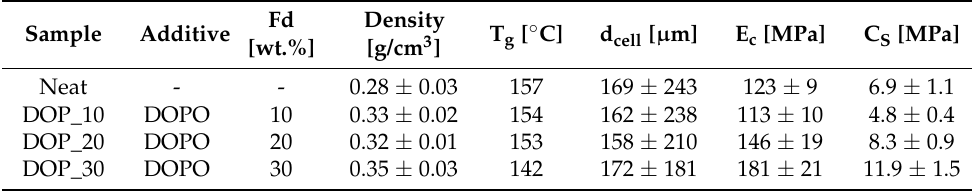
Figure 6. SEM images taken von EN/B-IPDA foams without particle modification, Neat ( a ), with DOPO 10 wt.% ( b ), 20 wt.% ( c ), 30 wt.% ( d ). Table 4. Specimens of DOPO fill study incl. comparison specimens: filler degree (Fd), density, T g , derived from DMA (Peak tan δ )., average foam cell diameter (d cell ), compression modulus (E c ), compressive strength (C s ).